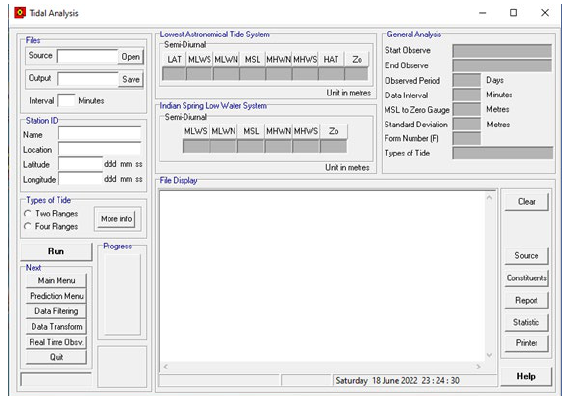
Figure 5. The main interface for tidal analysis in TOTIS